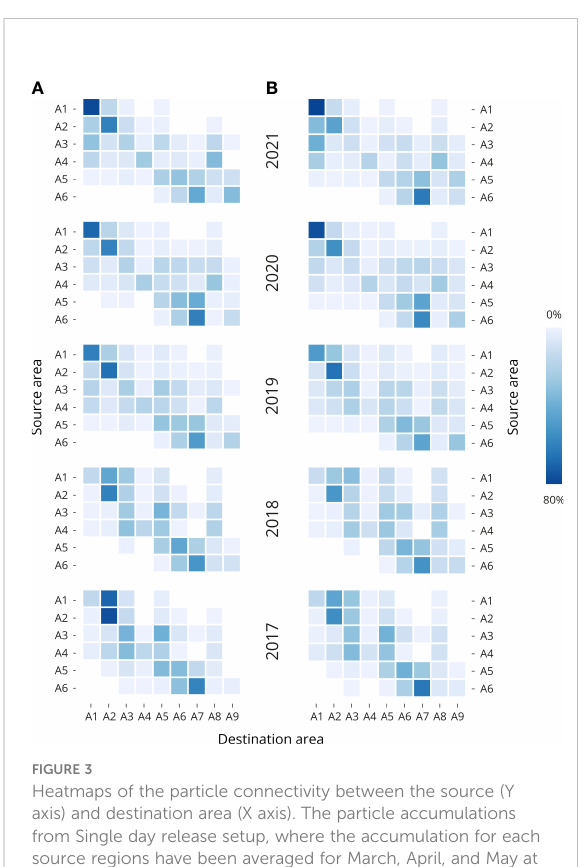
FIGURE 3 Heatmaps of the particle connectivity between the source (Y axis) and destination area (X axis). The particle accumulations from Single day release setup, where the accumulation for each source regions have been averaged for March, April, and May at 2 m, 6 m, and 10 m depth for the years 2021 to 2017; (A) 30-day release and (B) 45-day release with beginning points on 1 st March, 1 st April, and 1 st May 2021. Dark blue boxes corresponding to areas with higher particle accumulation and light blue to white boxes corresponding to areas with lower particle accumulation in percent. Detailed means and standard deviations are provided in Supplementary Table S2.